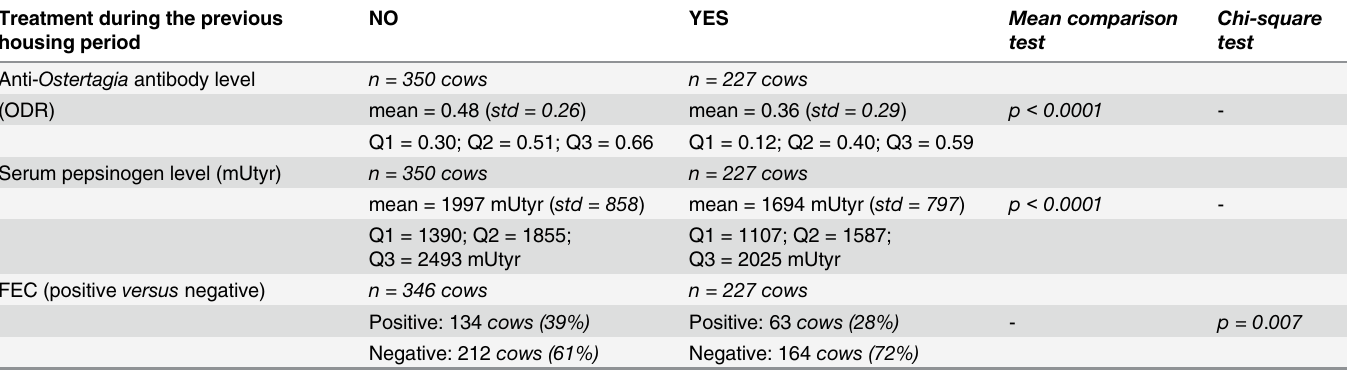
Table 5. Comparison of individual parasitological indicators measured 1.5 to 2 months after turn-out (second visit, spring 2012) according to the history of anthelmintic treatment applied during the previous housing period (autumn-winter 2011 – 2012). Treatment during the previous housing